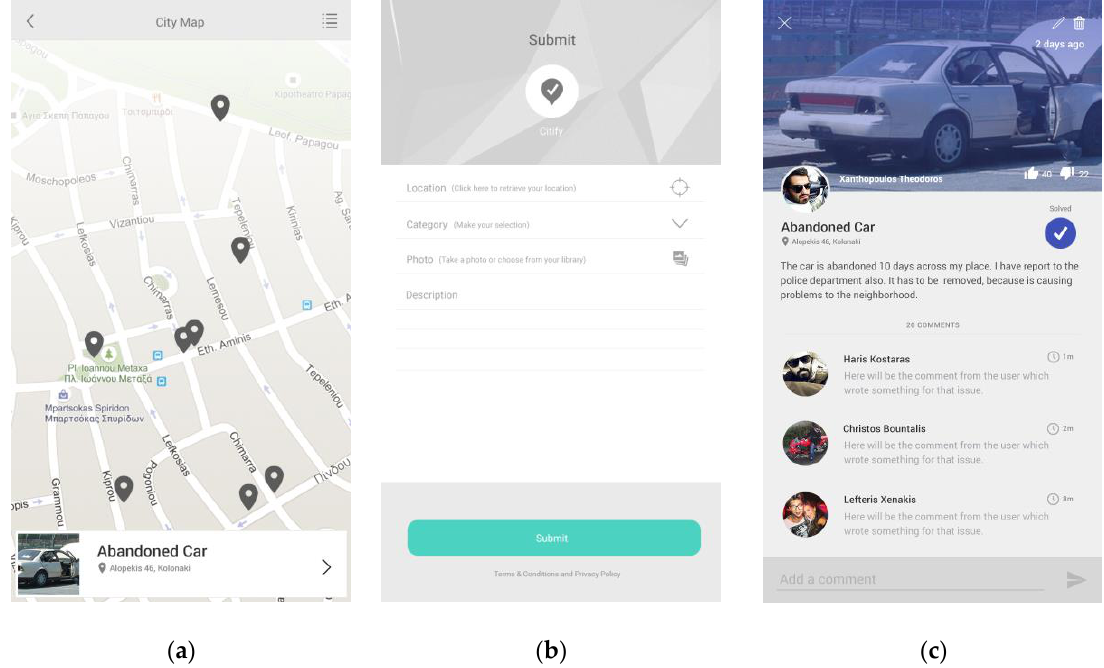
Figure 2. Three steps required to face the problem: ( a ) track the problem on the municipality map road address; ( b ) citizen annotates the problem and submits it to the system; ( c ) system informs citizen that the problem has been fixed.